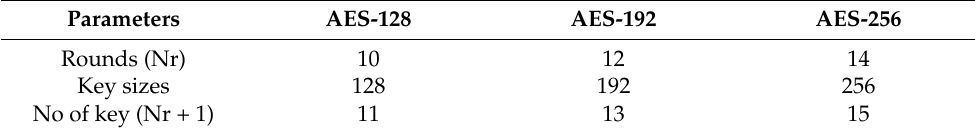
Table 1. Different types of